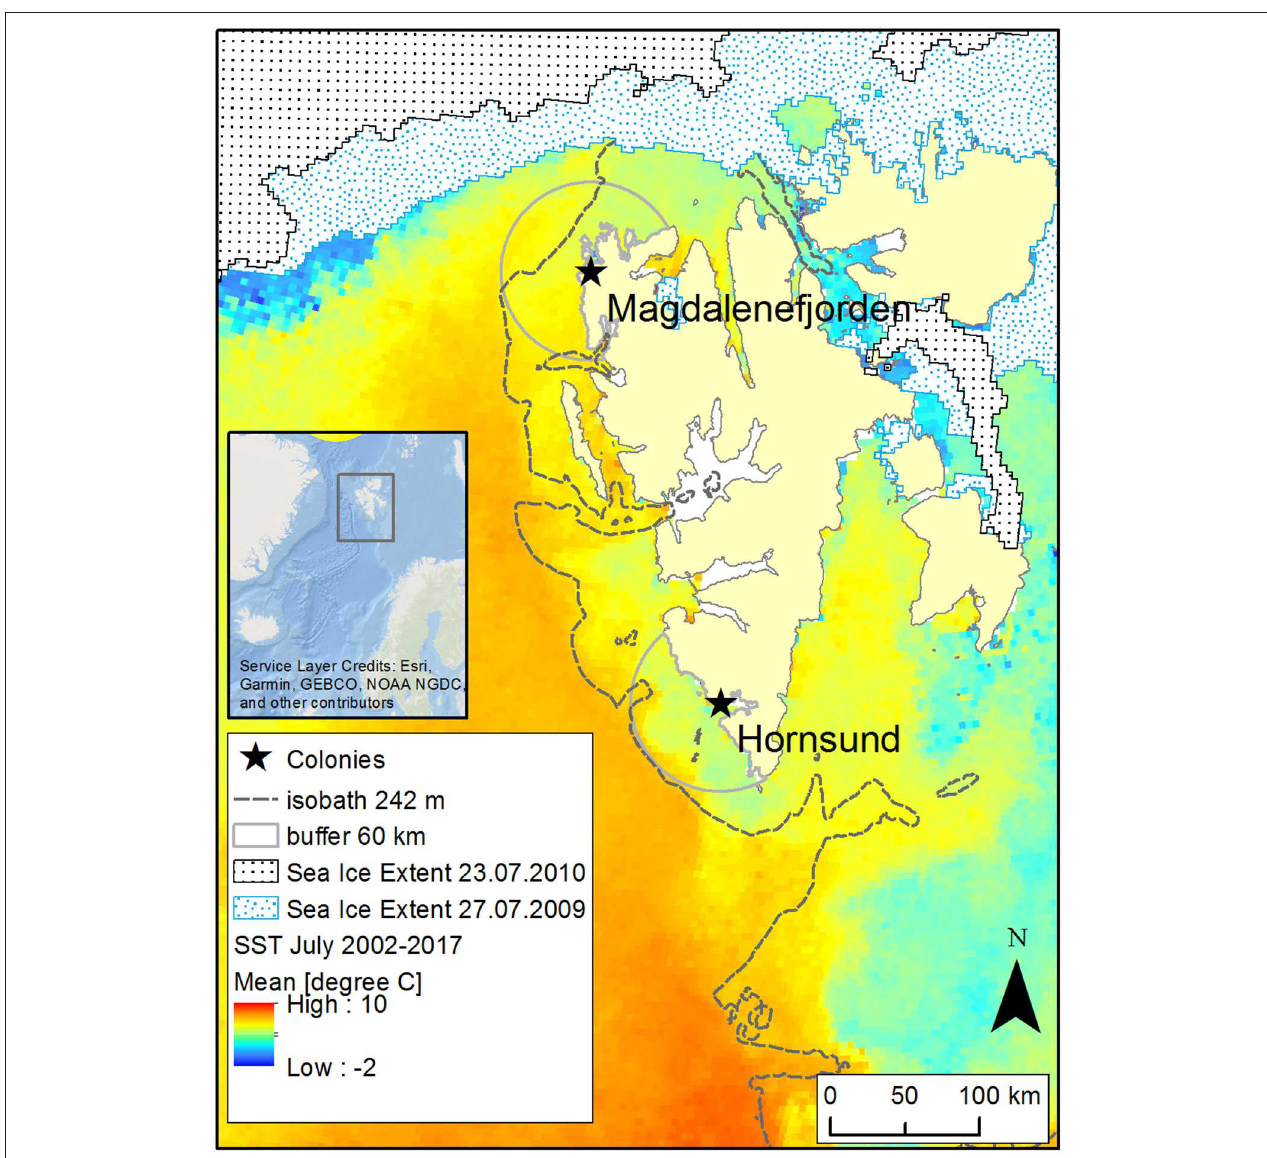
FIGURE 1 | Study area. Mean sea surface temperature (SST) values for July 2002–2017; the 242-m isobath represents the shelf break and boundary of the Arctic zooplankton community (Kwa´sniewski et al., 2012), and the 60-km buffers around the studied colonies represent close foraging grounds of Little Auks (Jakubas et al., 2017). Two example sea ice extents are shown for the dates when Little Auks were food sampled in both colonies. Data sources: SST: MODIS Aqua SST data (NASA Goddard Space Flight Center Ocean Biology Laboratory Ocean Biology processimg Group, 2014); sea ice extent: Multisensor Analyzed Sea Ice Extent - Northern Hemisphere (MASIE-NH), Version 1 with 4 215km grid cell size (National Ice Center (NIC) NSIDC, 2010); bathymetry: a 500m global relief model of Earth’s surface IBCAO ver. 3 (Jakobsson et al.,